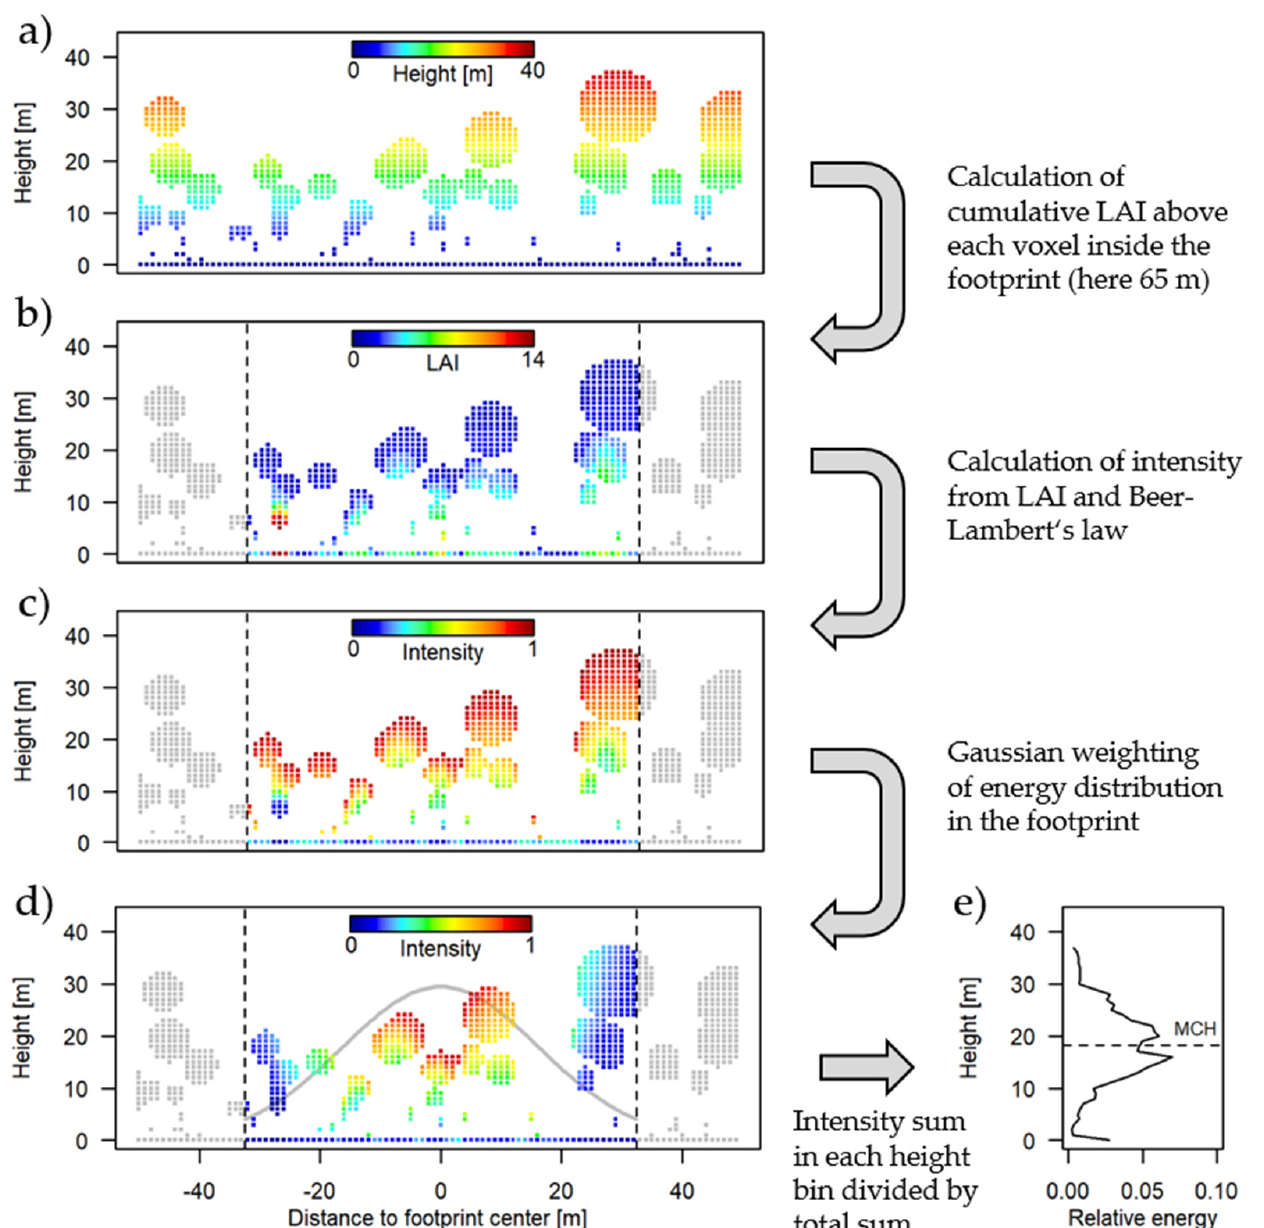
Figure 2. Workflow of the lidar waveform simulation. Shown is a 100 m-long transect (slice) across the voxel forest ( a ), for which a waveform with a 65 m wide footprint (ICESat GLAS) is simulated. Dashed lines mark footprint borders. The approach involves the calculation of the cumulative leaf area index ( b ), the calculation of light extinction ( c ), Gaussian weighting around the footprint center ( d ) and aggregation to derive the waveform ( e ) from which the mean canopy height (MCH) is calculated.